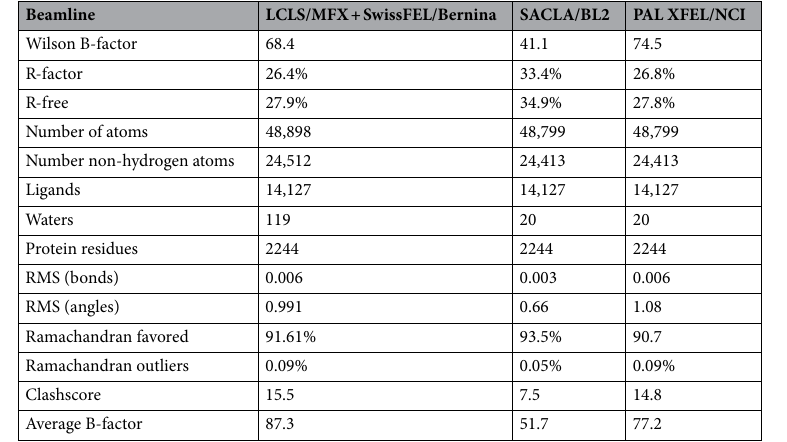
Table 2. Refinement statistics PDB ID 7M75 7M78 7M76.